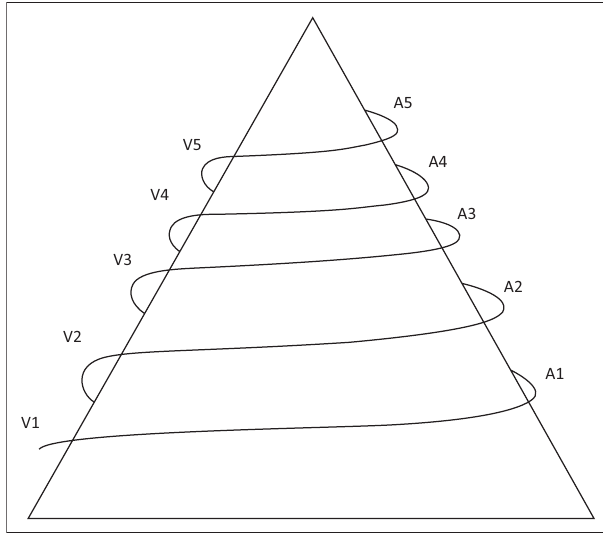
FIGURE 1: The visualisation/analysis